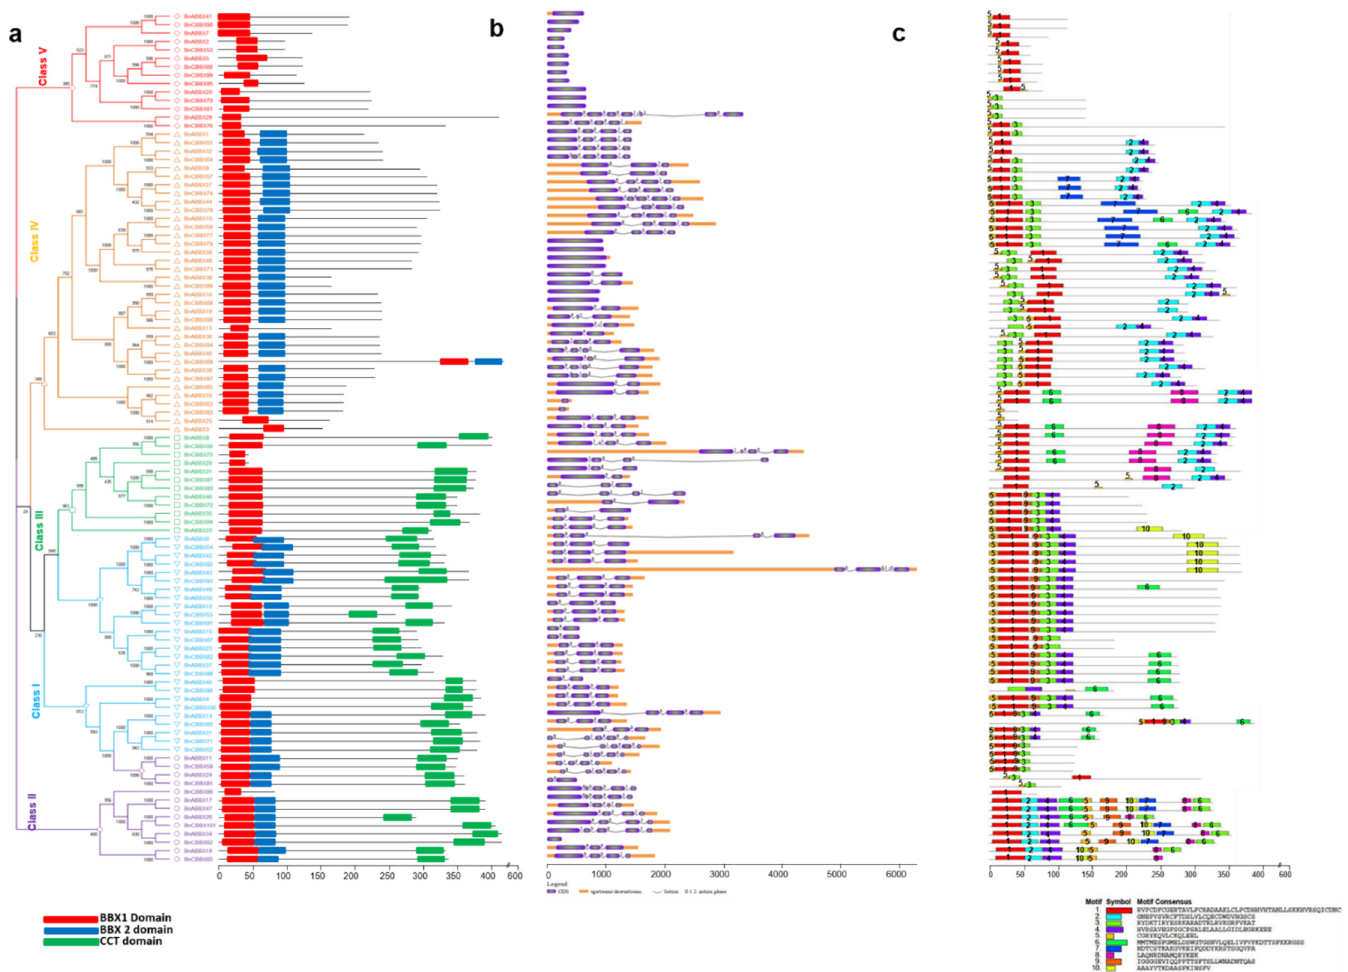
Figure 6. Brassica napus B-box gene structures ( a ), motifs ( b ), and conserved domains ( c ). The domain architecture of the B-box genes is presented in panel a. Exons are represented by colored boxes, whereas introns are indicated by gray lines ( b ). Colored boxes indicate conserved motifs and gray lines represent non-conserved sequences. The motif lengths in each protein are presented proportionally. Classes I–V represent different groups of B-box family members in B. napus.